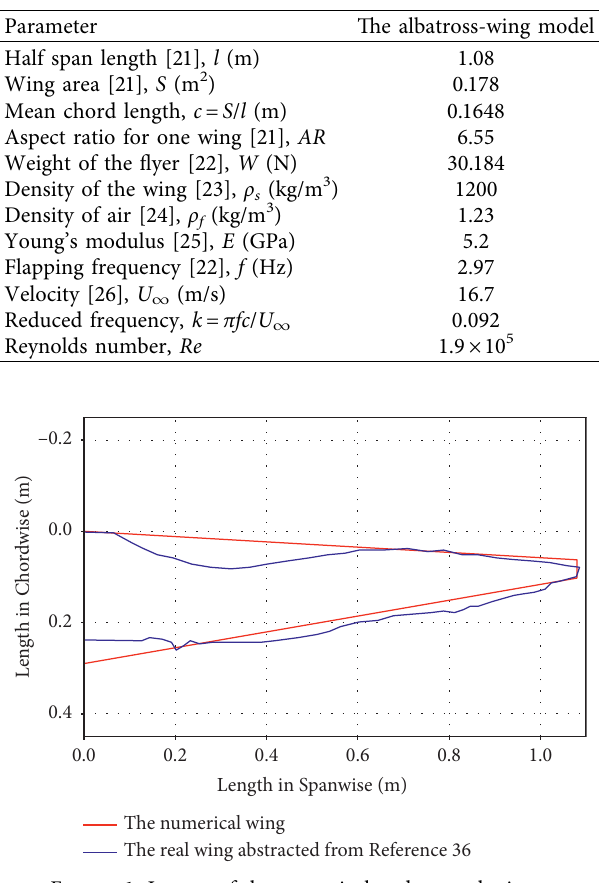
Table 1: Wing morphological parameters of the numerical alba- tross-wing